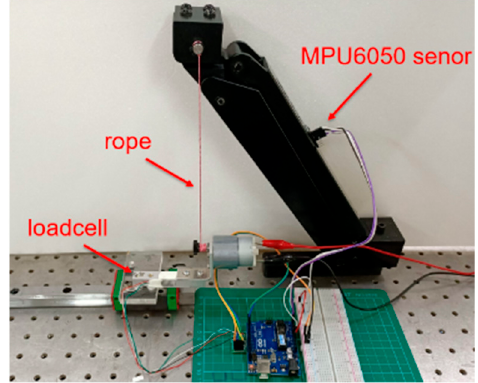
Figure 2. Photograph of the loadcell and MPU6050 sensor.